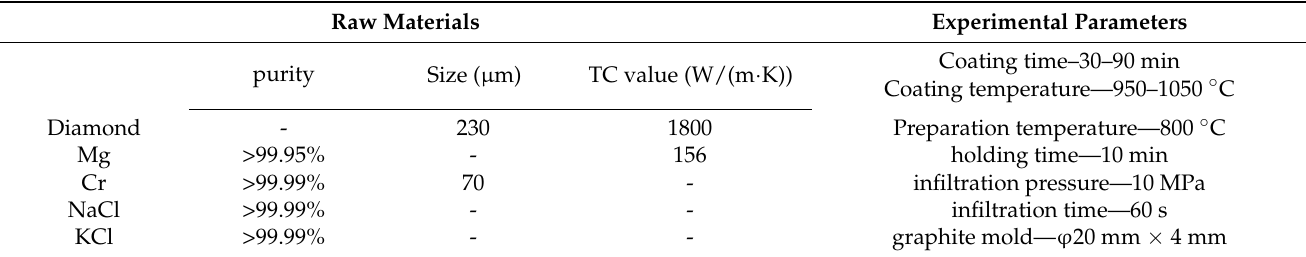
Table 1. Raw materials and experimental parameters. Raw Materials Experimental